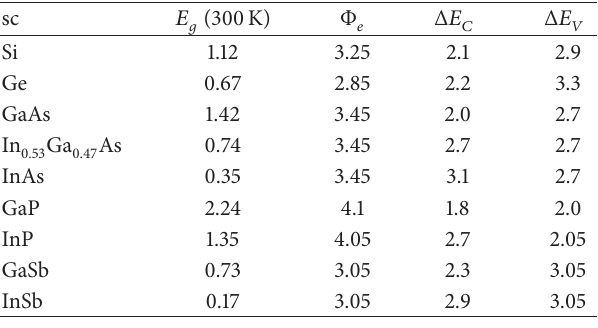
Table1:Bandgapwidthofseveralsemiconductors( 𝐸 𝑔 ),theelectron photoemission barrier ( Φ 𝑒 ), and the corresponding CB and VB offsets Δ𝐸 𝐶 and Δ𝐸 𝑉 at the interfaces with a-Al All energies are in eV ( ± 0.1eV).